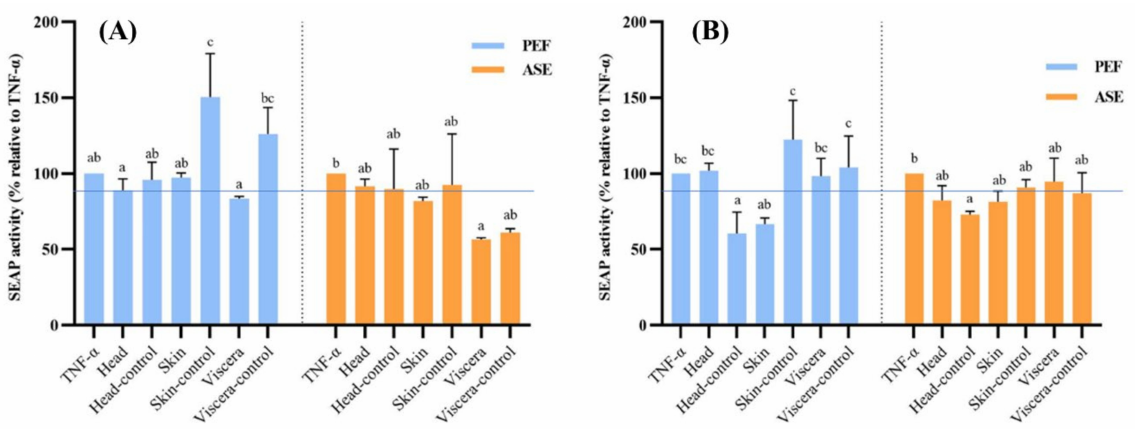
Figure 3. The NF- κ B activation induced by TNF- α and the effect of fish by-product extracts using different treatment technology (PEF/ASE) were determined. ( A ) rainbow trout and ( B ) sole; the SEAP activity induced by TNF- α was considered to be 100%. PEF: pulsed electric fields; ASE: accelerated solvent extraction; Different lowercase (a–c) letters in the figure indicate statistically significant differences ( p <